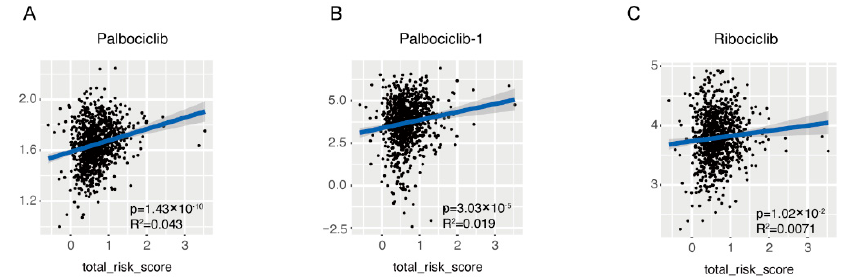
Figure 7. Association of the risk score with the sensitivity of CDK4/6 inhibitor. Linear association between risk score and IC50 of first line CDK4/6 inhibitors was demonstrated in dot plot, including Palbociclib ( A , B ) and Ribociclib ( C ).